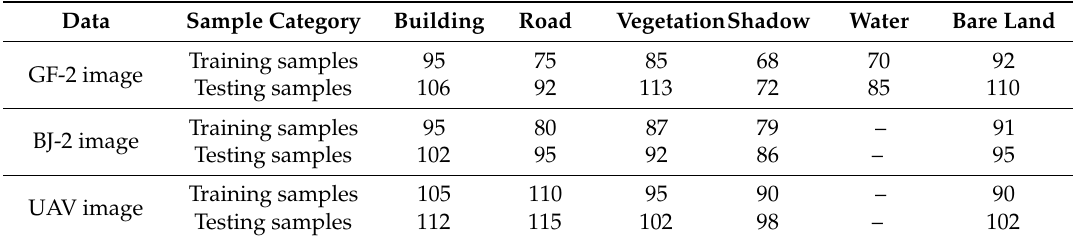
Table 3. Sample statistics selected from different high-resolution images.